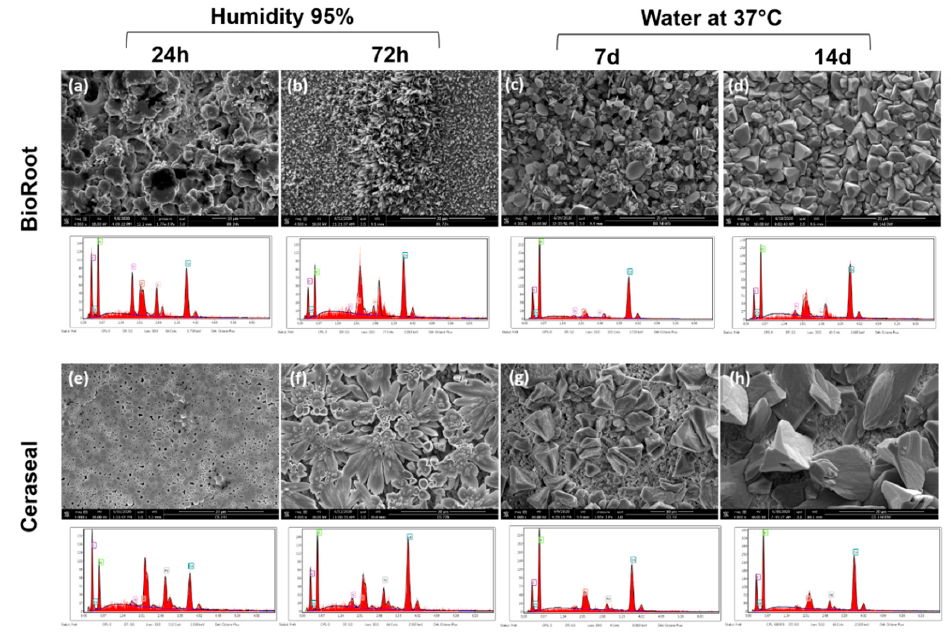
Figure 5. Representative scanning electron microscope images at 4000× magnification ( a – h ) and energy-dispersive X-ray (EDX) spectrums. The morphology and EDX spectrum observed for the BioRoot ( a – d ) and Ceraseal ( e – h ) surfaces after 24 and 72 h in humidity, 7 and 14 d in water at 37 ◦ Table 4. The mass percentages of the main element compounds of BioRoot and Ceraseal surfaces in